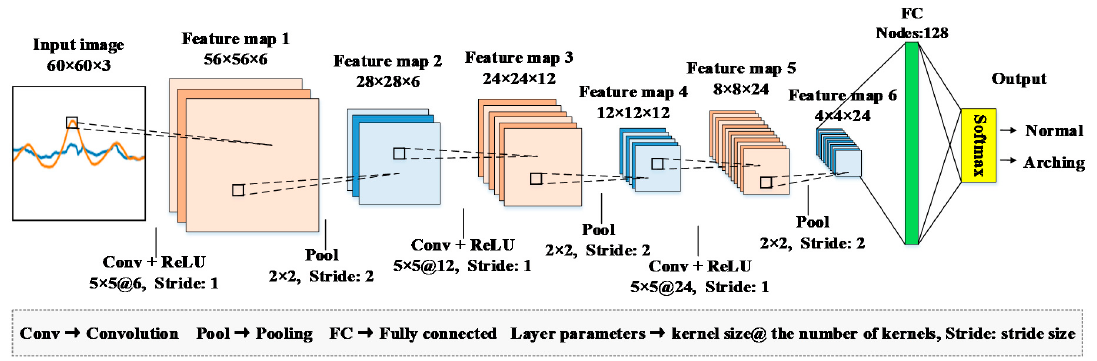
Figure 10. Final architecture of the convolutional neural network (CNN) detection model.